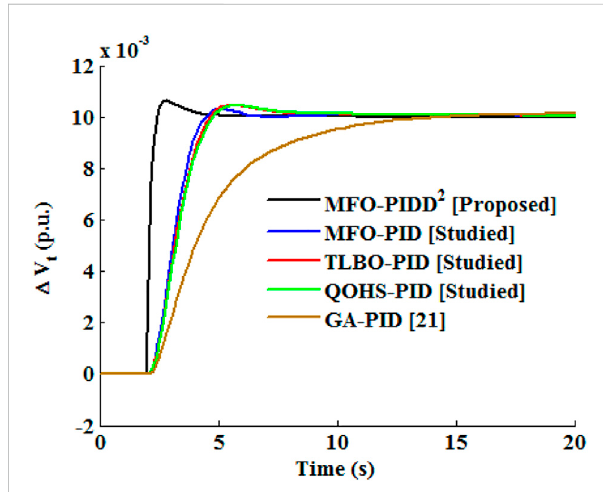
FIGURE 9 Typical comparative voltage response pro fi les of the online SFL